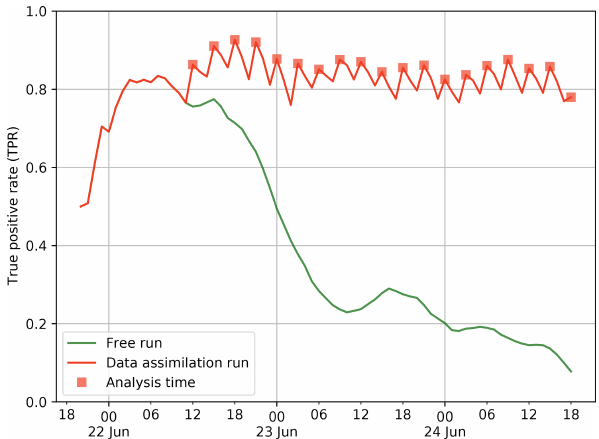
Figure 12. Temporal evolution of the probability of detection (POD) metrics according to the free and data assimilation runs for the Raikoke experiment. A localisation radius of L R = 2 ◦ was de- fined for the data assimilation